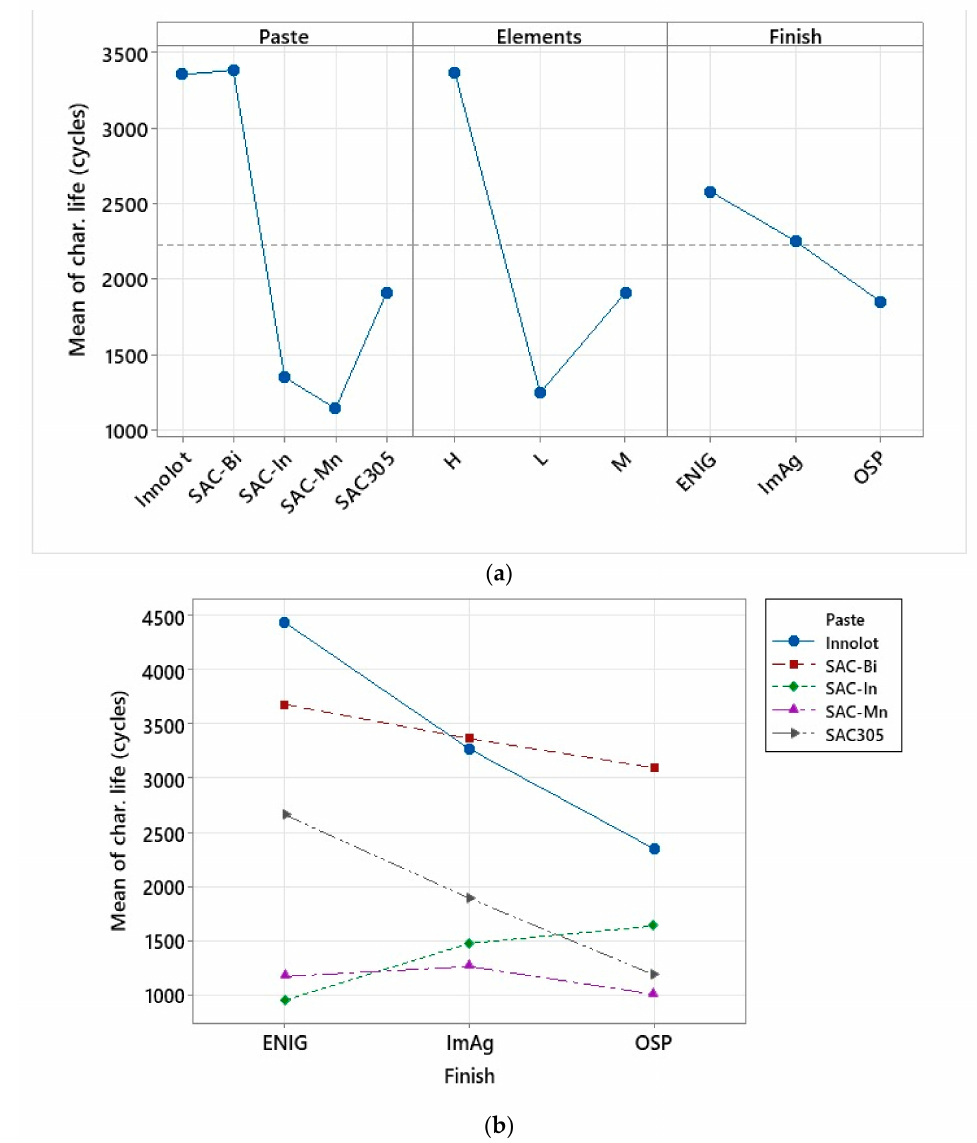
Figure 7. ANOVA analysis; ( a ) main effect plots including paste, elements, and surface finish; ( b ) Interaction effects plot for different alloys and surface